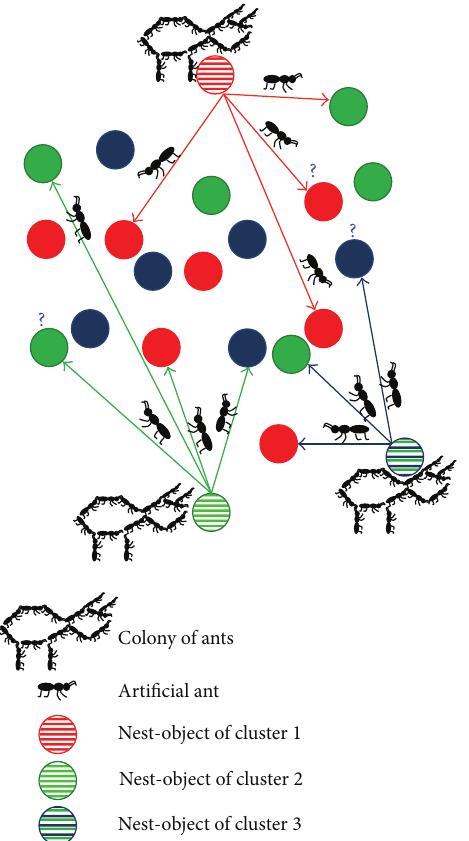
Figure 1: Graph used in ASClass algorithm [38].